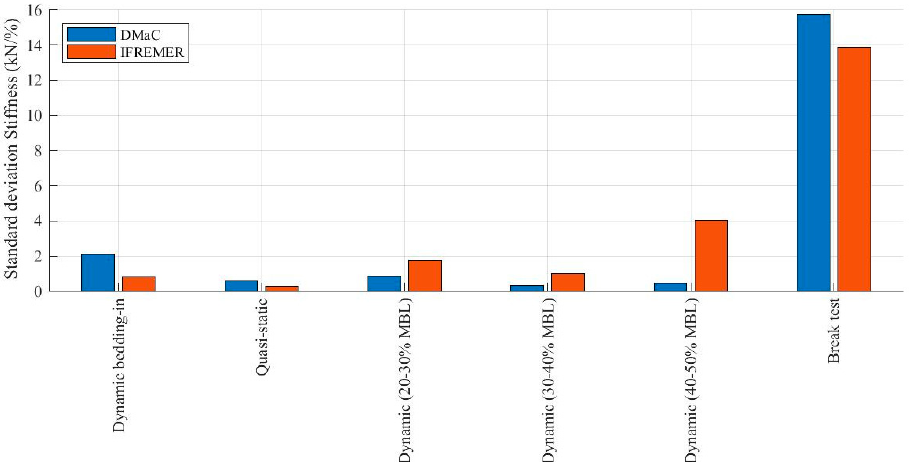
Figure 13. Comparison of the standard deviation in stiffness properties of the hybrid rope determined at DMaC and IFREMER.